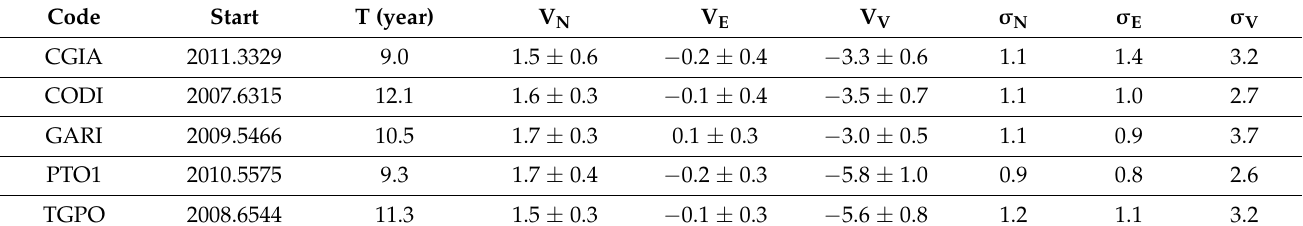
Table 1. Velocities in mm/year of CGNSS stations located in the PRD and surrounding areas, adopted in the processing of the network as references (CGIA, CODI, GARI) and benchmarks (PTO1, TGPO). In the first and second columns are reported the CGNSS station codes and the date (T), in decimal year, of the first observation used in the processing, respectively. V are the velocities in the ETRF2014 reference frame [63] of the North (V N ), East (V E ), and Vertical (V V ) components. The uncertainties associated with the velocities were estimated using the method suggested by [66]. The Weighted Root Means Square values ( σ ) in mm/year of the analyzed time-series are shown in the last three columns.